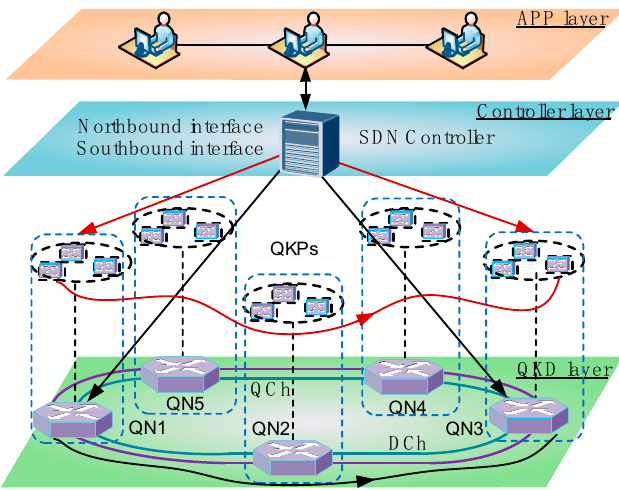
Figure 3. The architecture of QKD network enabled by SDN.